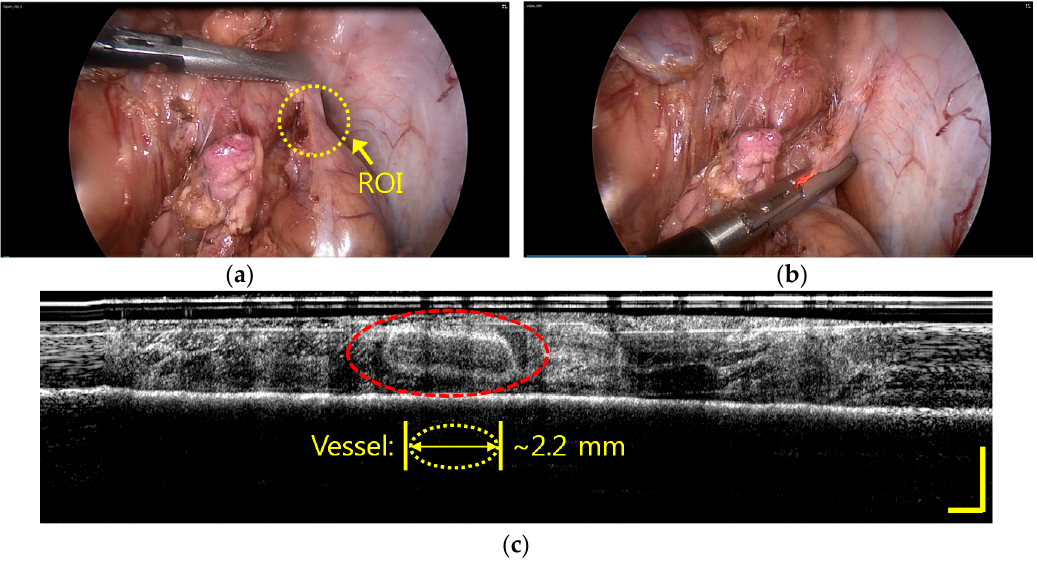
Figure 6. In vivo imaging inside the fatty tissue of a porcine model with IGLaST; the blood vessel inside the tissue is visible. ( a ) Laparoscopic image of the porcine model. ( b ) Laparoscopic image of the porcine model after the tissue is grasped with IGLaST. ( c ) OFDI image inside the fatty tissue.